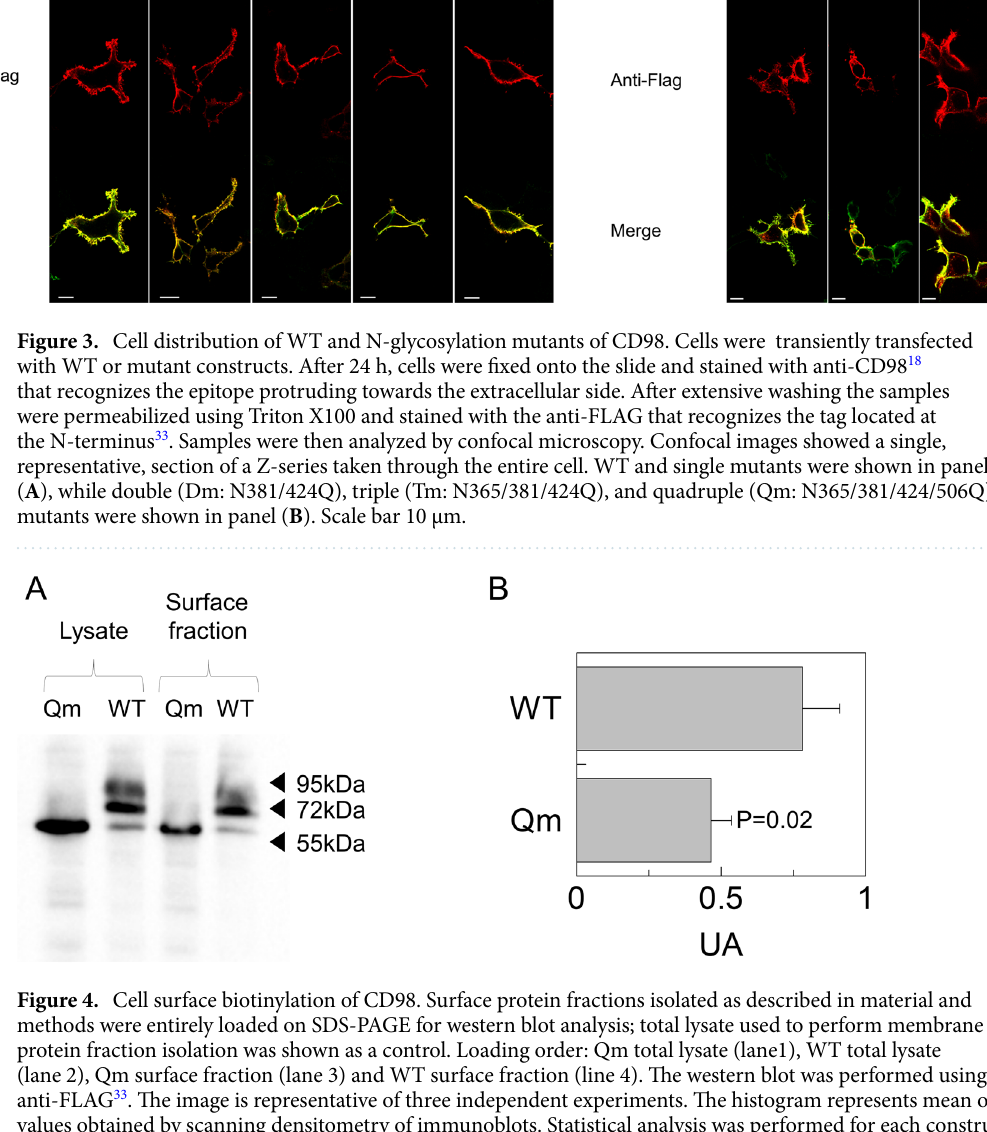
membrane and used in confocal analyses 33 . In order to find optimal detection times after brefeldin treatment,